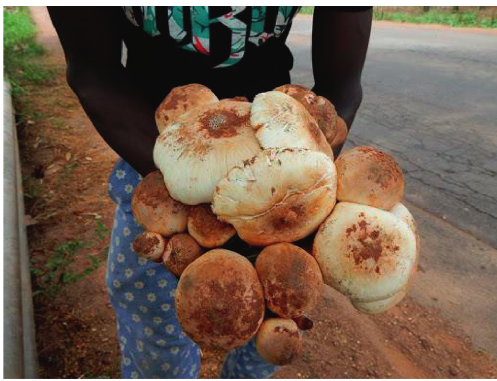
Figure 1: Photography of T. le-testui